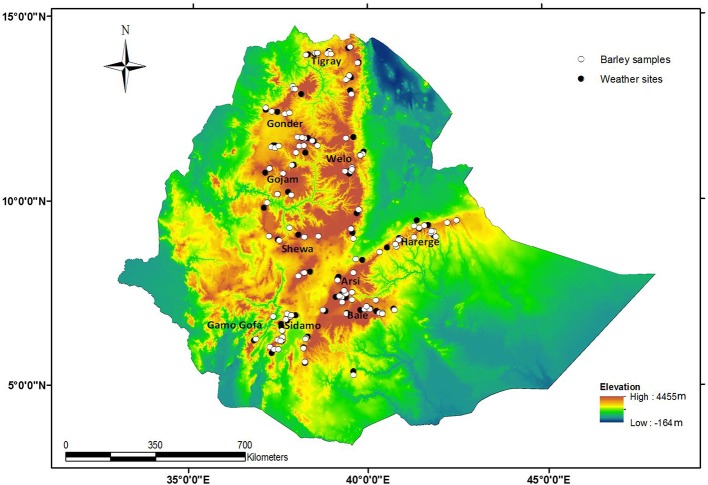
Distribution of barley landraces and weather sites across Ethiopia on an altitudinal map.